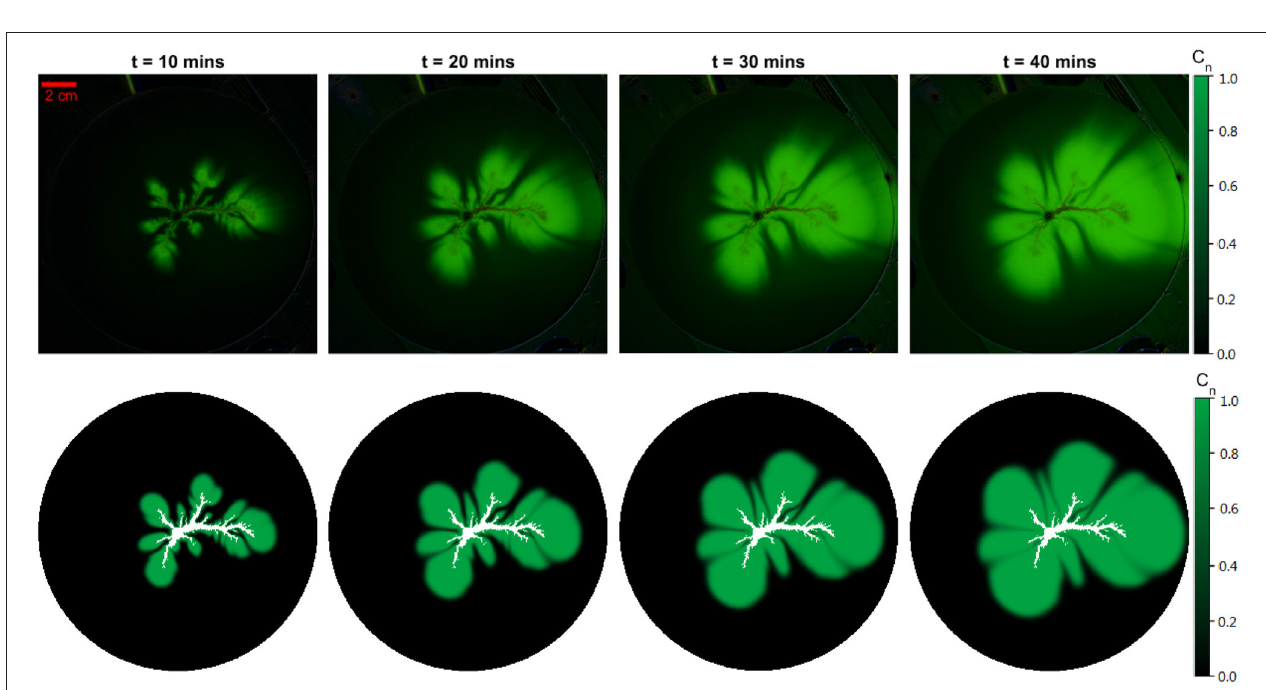
FIGURE 3 | Experimental results compared with simulation images. (Top) Experimental images subtracted by the initial state image. (Bottom) Simulation output of the dissolution pattern. The boundary conditions are extracted from the experimental image before fluid flow begins. The green intensity represents the normalized tracer concentration C n in the simulation. The vertical pairs of images show comparison after an injection lasting respectively 10 / 20 / 30 / 40 min, which gives a qualitative description of the similarity between the experiments and simulations.